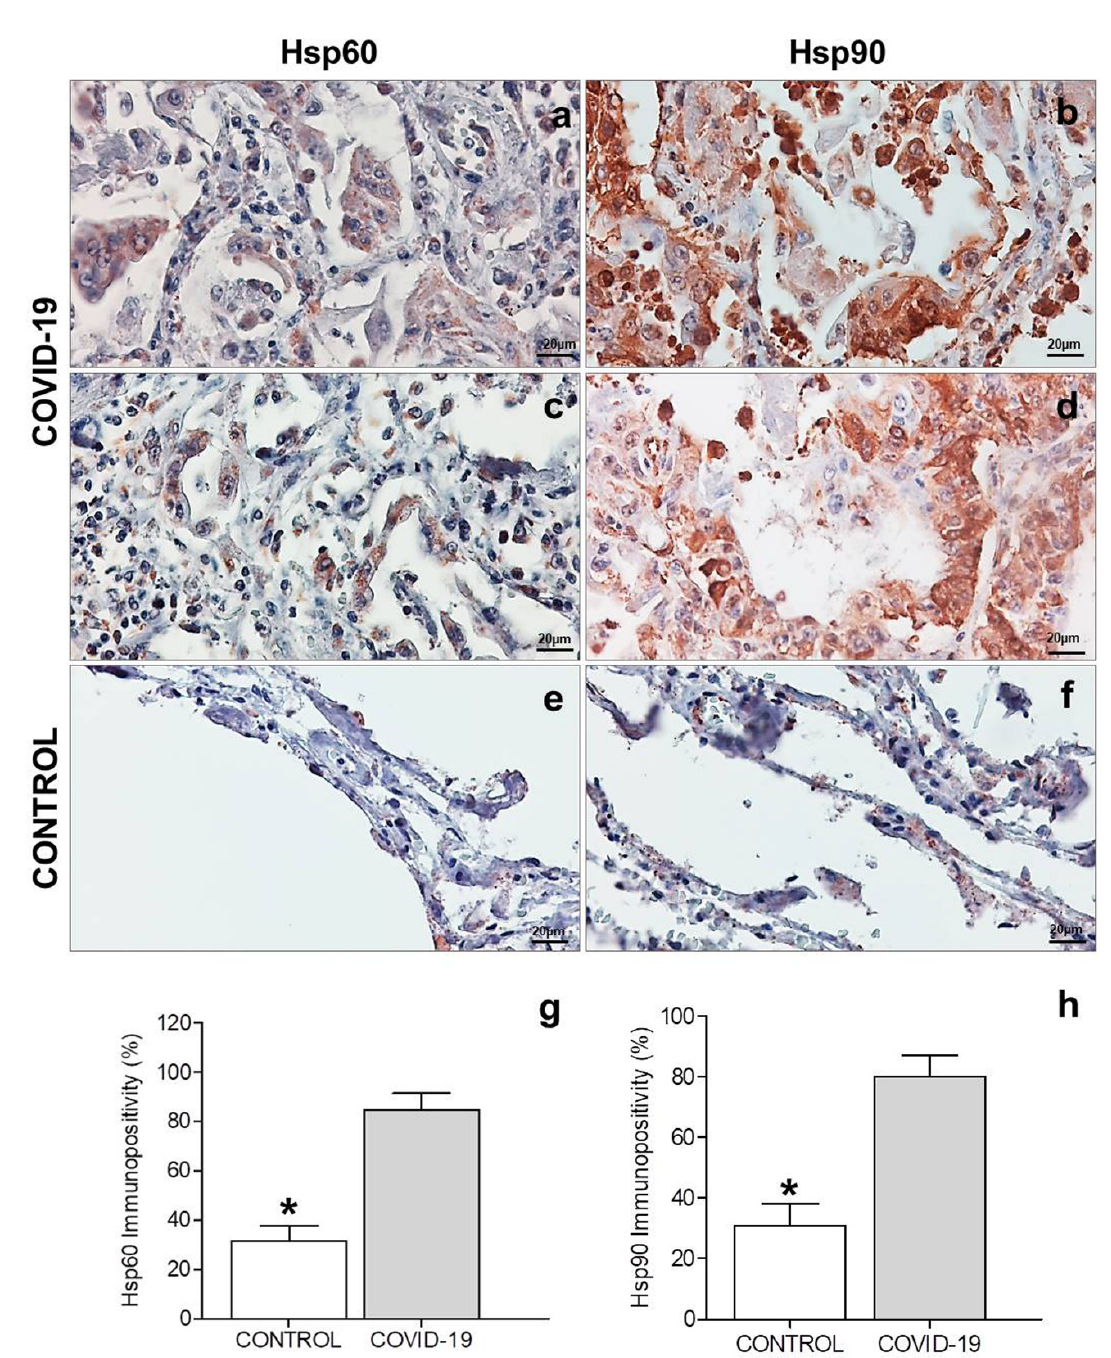
Figure 2. Immunohistochemistry for Hsp60 and Hsp90. ( a , c , e ) Representative images of immunohistochemical detection of Hsp60 in lung parenchyma of the COVID-19 and control groups. ( g ) Histogram showing the percentage of Hsp60-positive epithelial cells in the control and COVID-19 groups. ( b , d , f ) Representative images of immunohistochemical detection of Hsp90 in lung parenchyma of the COVID-19 and control groups. ( h ) Histogram showing the percentage of Hsp90-positive epithelial cells in the COVID-19 and control groups. Magnification 400 × , scale bar 20 µ m. Data are presented as the means ± SD. * : p < 0.0001.